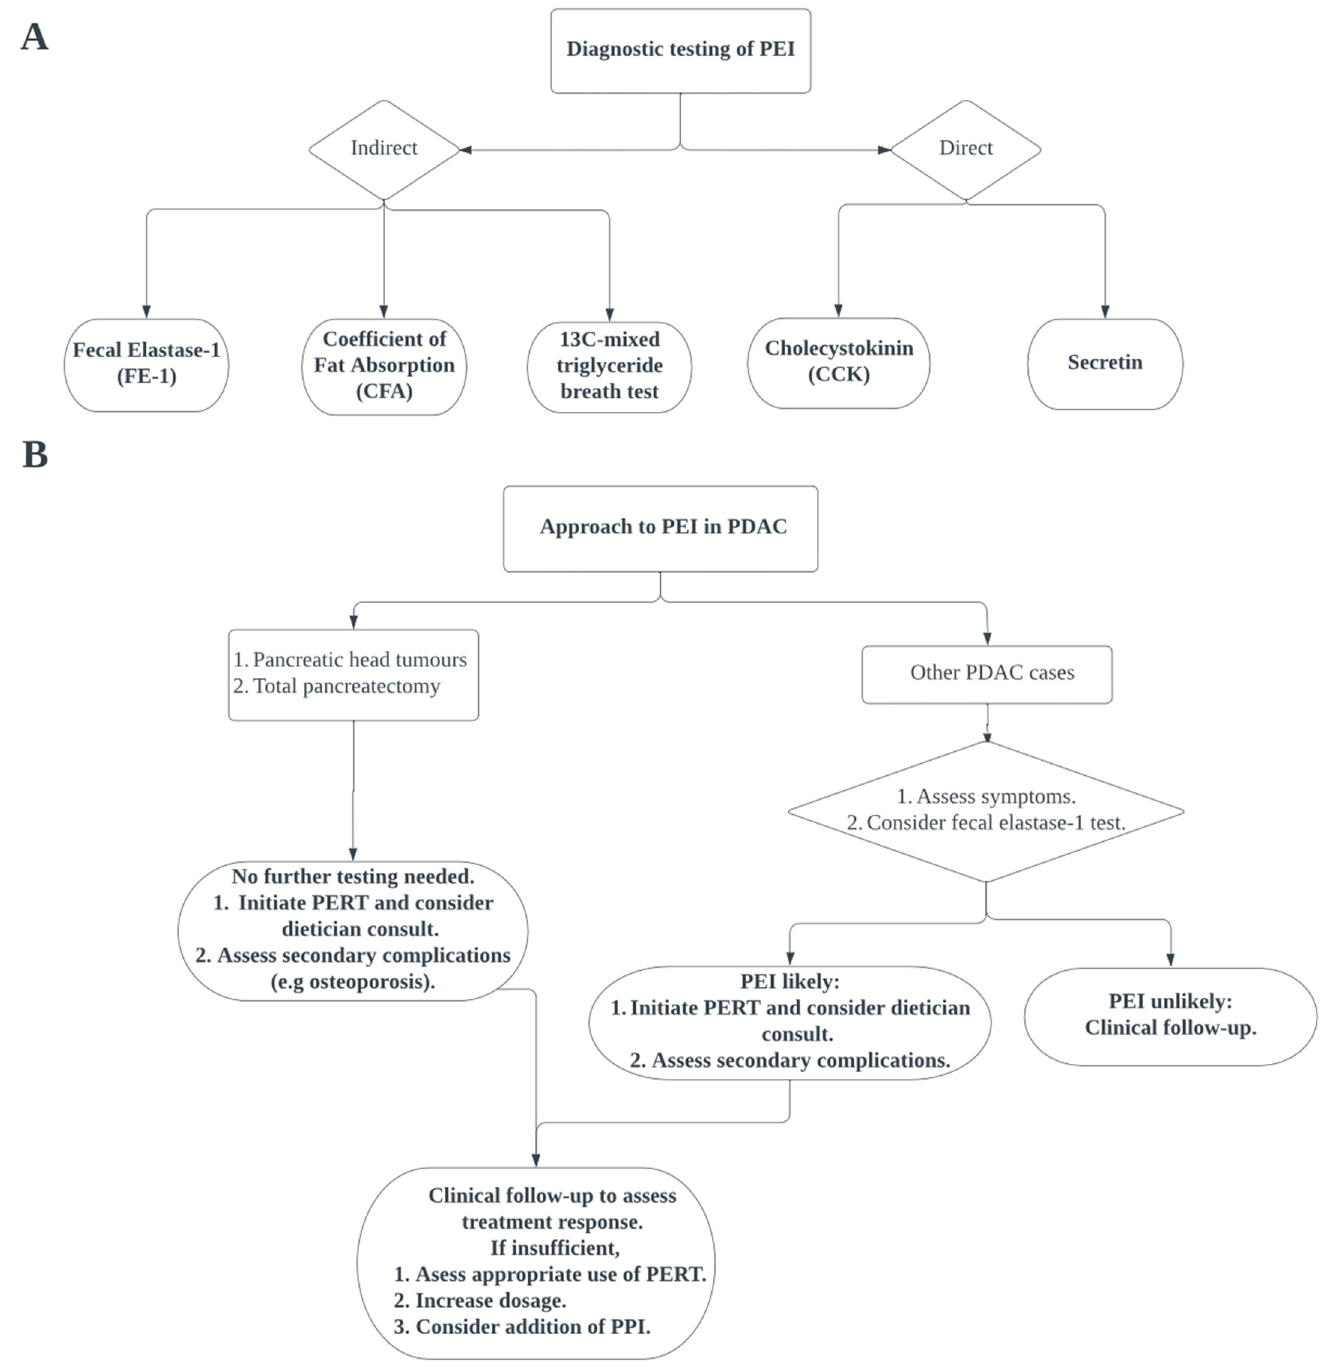
Figure 1. Suggested diagnostic testing ( A ) and approach ( B ) to pancreatic exocrine insufficiency (PEI) among patients with pancreatic ductal adenocarcinoma (PDAC).